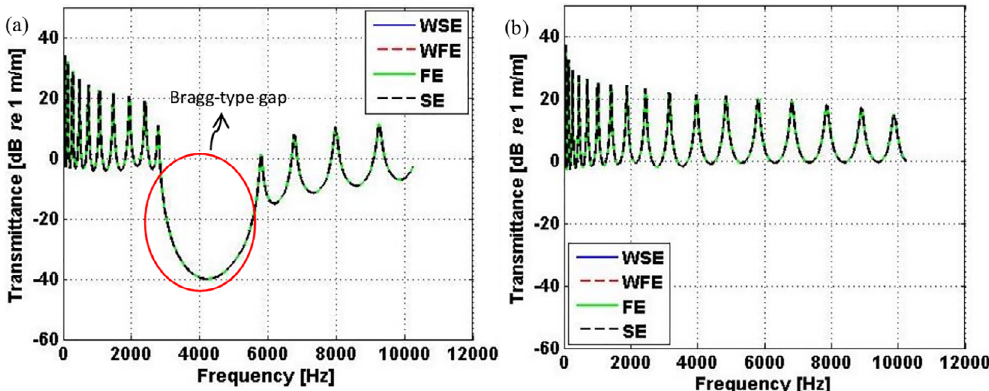
Figure 4. Transmittance of the PC beam calculated by WSE, WFE, FE and SE methods, considering models 1 (a) and 2 (b).